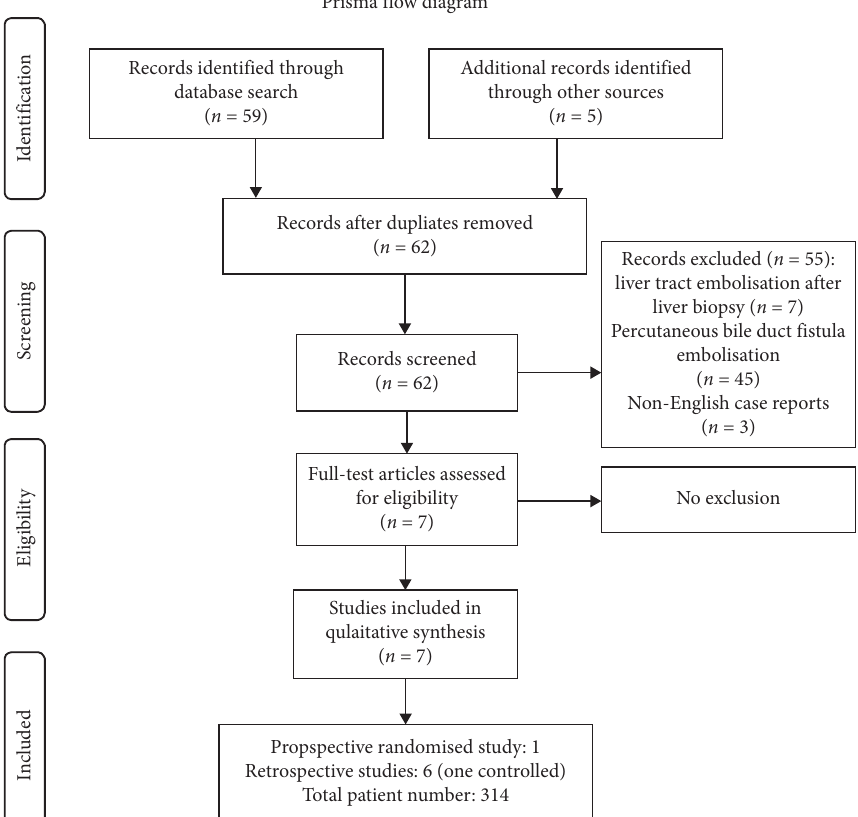
Figure 2: Screening and inclusion process are shown in a flow diagram according to the PRISMA statement (http://www.prisma-statement.